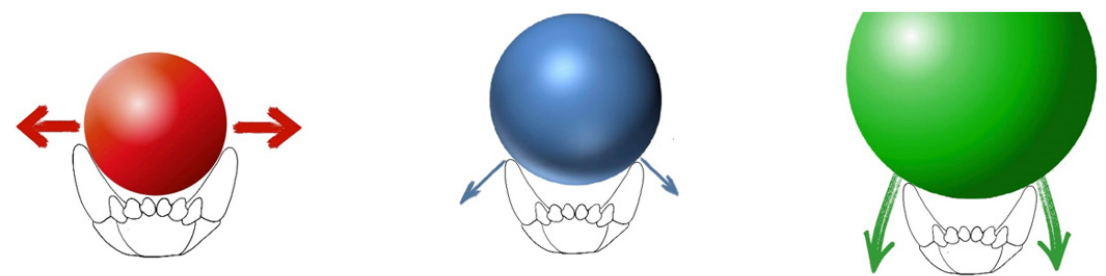
Figure 12. Selecting the size of the ball to the lower interdental width. The red ball only stretches and thus protrudes the teeth. The blue one is intrusive and tilts the teeth. The green ball is only intrusive.